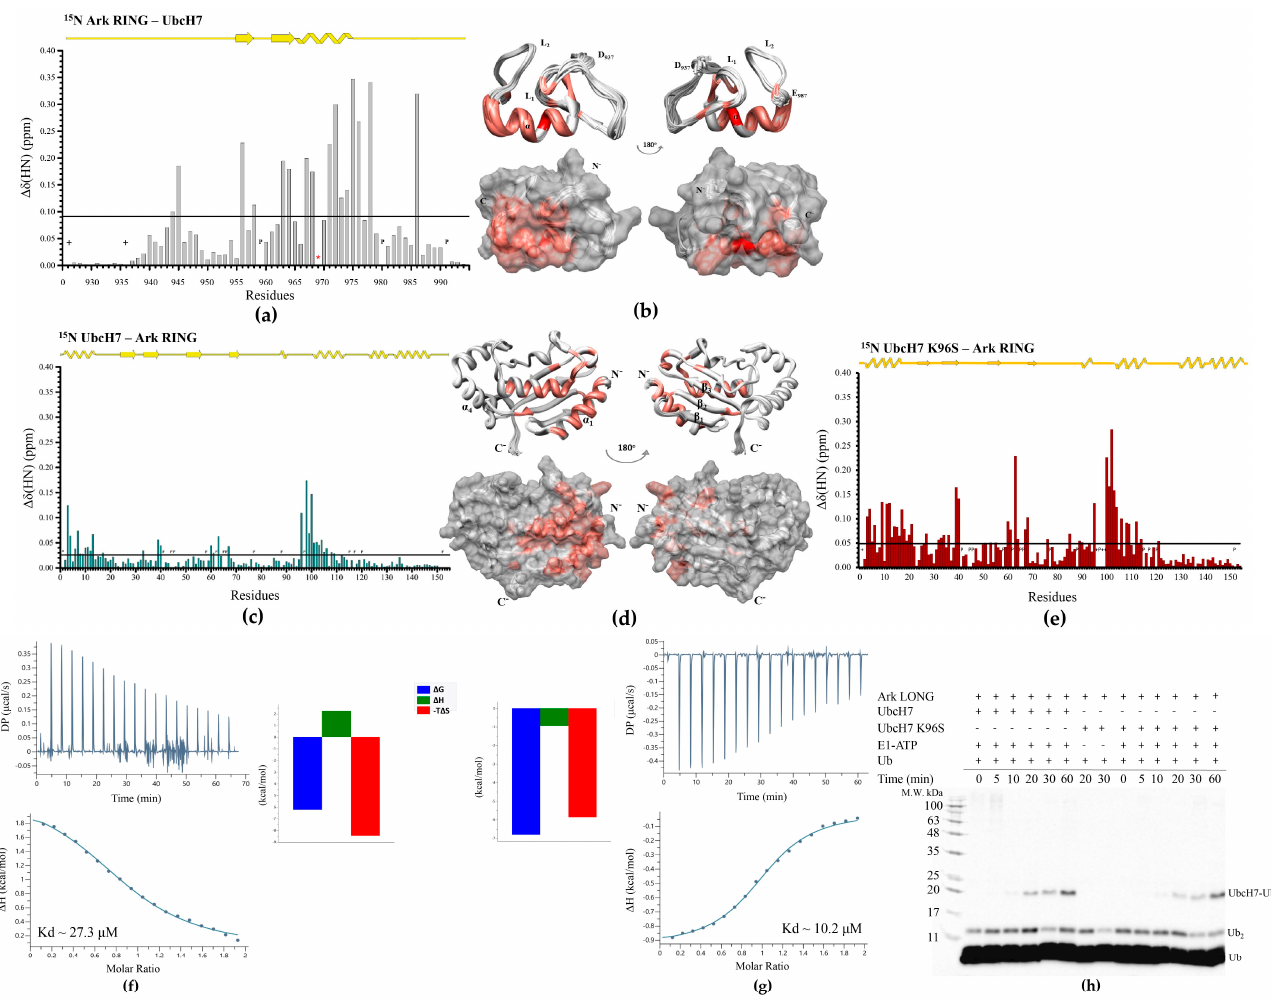
Figure 3. Interaction of E3 Arkadia with wt UbcH7 and UbcH7 K96S mutant. ( a ) Diagram of the total CSPs measured at a 1:2 molar ratio (saturation point) for 15 N Ark RING/ 14 N wt UbcH7, *: represents disappeared residues, +: represents residues with no information. ( b ) Ark RING mapping (PDBid: 2KIZ) after the addition of UbcH7 (residues that disappeared during the interaction are colored red, whereas residues that exhibited ‘fast exchange’ interaction are colored coral). ( c ) Diagram of the total CSPs measured at a 1:1.5 molar ratio for 15 N UbcH7/ 14 N Ark RING. ( d ) UbcH7 mapping (PDBid: 6XXU) after the addition of Ark RING. ( e ) Diagram of the total CSPs measured at a 1:1.5 molar ratio for 15 N UbcH7 K96S/ 14 N Ark RING. ( f ) ITC data for the titration of wt UbcH7 into Ark RING and ( g ) UbcH7 K96S into Ark RING. ( h ) In vitro auto-ubiquitylation assays of Ark LONG using wt UbcH7 and UbcH7 K96S, respectively.